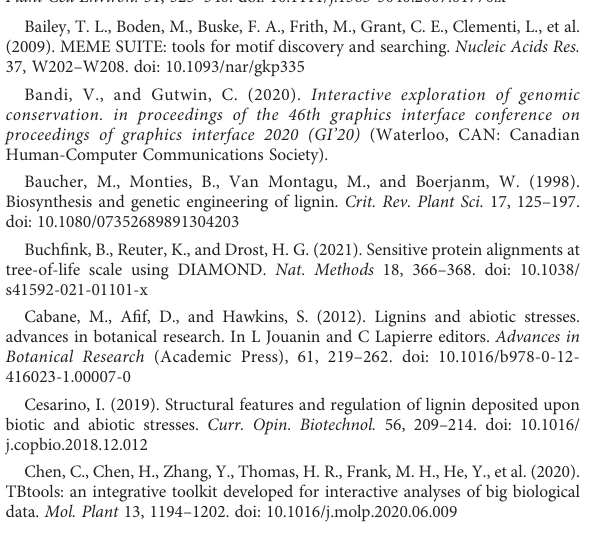
SUPPLEMENTARY FIGURE 1 Proline and phenolic content in C. olitorius in response to abiotic stress were measured. The accumulation was assessed in two-month-old jute seedlings under various stress conditions, such as salt (200 mM NaCl), drought (20% PEG), and hormone (20 uM ABA), as well as related control samples. The mean value and standard deviation (n = 3) were used to represent the results. (A) proline content in leaf and stem tissue under stress. (B) phenolic content in leaf and stem tissue in response to stress. Columns followed by the different letters are statistically signi fi cantly different according to P value ≤ 0.05. SUPPLEMENTARY FIGURE 2 Syntenic relationship between two jute genomes ( C. capsularis and C.